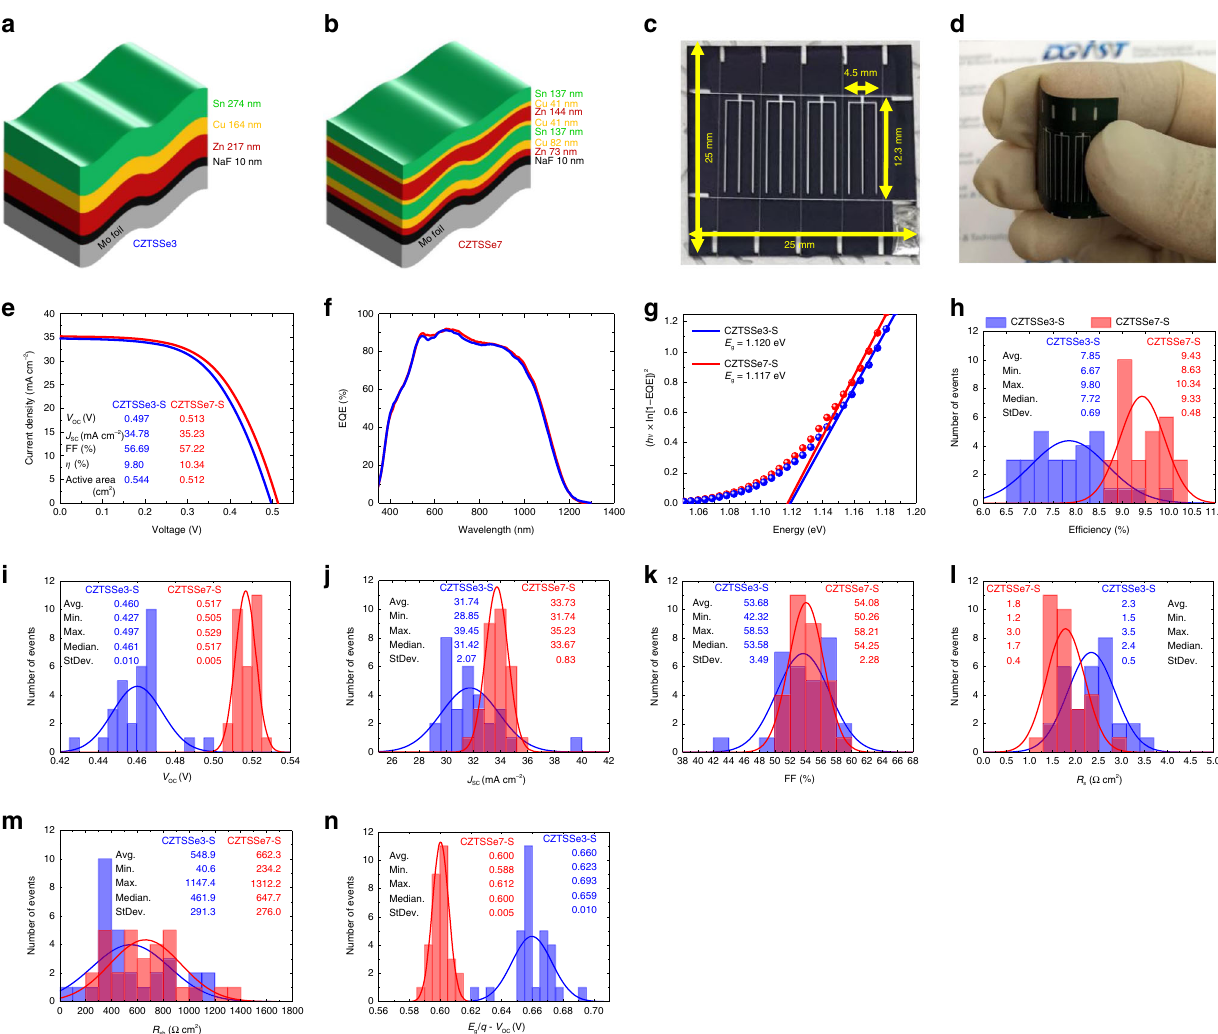
Fig. 1 Photovoltaic device properties of fl exible CZTSSe3-S and CZTSSe7-S. a 3-Stacked and b 7-stacked precursor structures. c Four cells ~4.5 mm × 12.3 mm in size are included in the Mo foil substrate, which is ~25 mm × 25 mm in size and d fl exed sample image. All samples are with a small cell area of ~0.5 m 2 for 30 devices of each type. e Current density-voltage curves, f EQE curves at a bias of 0 V, and g calculated bandgaps of CZTSSe3-S and CZTSSe7-S samples with the highest ef fi ciencies (from KIER certi fi cate, Supplementary Fig.1 and 2). h The average ef fi ciency values are 7.85% with a StDev of 0.69 for CZTSSe3-S and 9.43% with a StDev of 0.48 for CZTSSe7-S. i The average V OC values are 0.460 V with a StDev of 0.010 for CZTSSe3-S and 0.517 V with a StDev of 0.005 for CZTSSe7-S. j The average J SC values are 31.74 mA cm − 2 with a StDev of 2.07 for CZTSSe3-S and 33.73 mA cm − 2 with a StDev of 0.83 for CZTSSe7-S. k The average FF values are 53.68% with a StDev of 3.49 for CZTSSe3-S and 54.08% with a StDev of 2.28 for CZTSSe7-S. l The average R s values are 2.3 Ω cm 2 with a StDev of 0.5 for CZTSSe3-S and 1.8 Ω cm 2 with a StDev of 0.4 for CZTSSe7-S. m The average R sh values are 548.9 Ω cm 2 with a StDev of 291.3 for CZTSSe3-S and 662.3 Ω cm 2 with a StDev of 276.0 for CZTSSe7-S. n The average V OC de fi cit ( E g /q − V OC ) values are 0.660 V with a StDev of 0.010 for CZTSSe3-S and 0.600 V with a StDev of 0.005 for